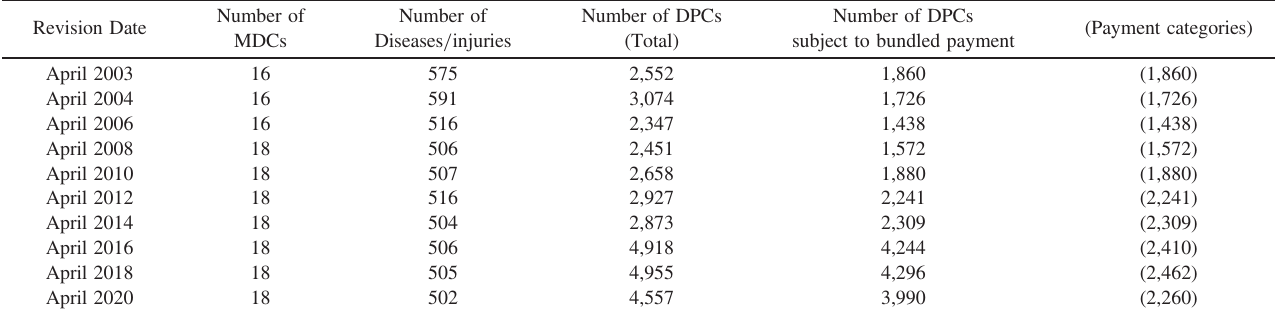
Table 2. Changes in the number of